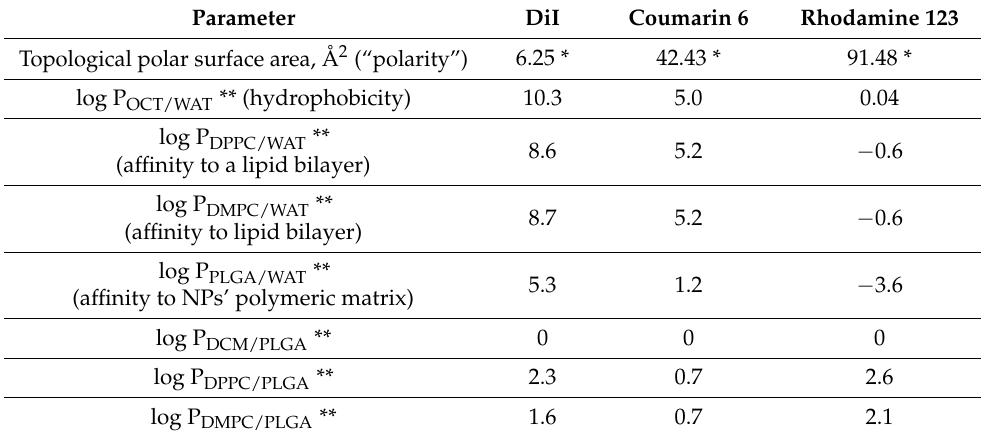
Table 3. Calculated parameters of the dyes’ distribution in different phases. Parameter DiI Coumarin 6 Rhodamine 123 Topological polar surface area, Å 2